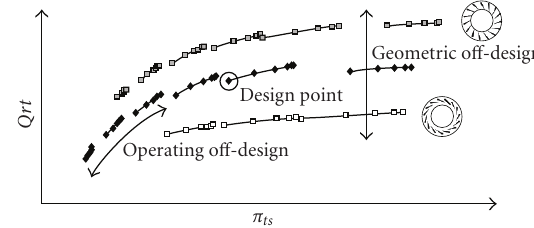
Figure 1: O ff -design